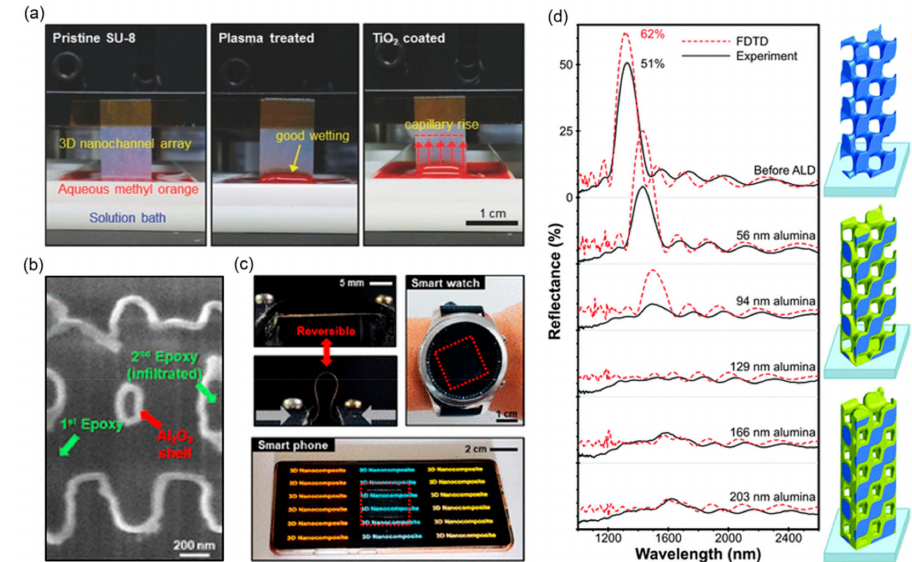
Figure 6. Application of inorganic shell-polymer nanonetwork composites: ( a ) comparison of hydrophilicity before and after conformal coating of TiO 2 thin film on ultralong nanochannel arrays formed by PnP (reprinted with permission from [23]. Copyright 2015 John Wiley and Sons); ( b ) cross-sectional SEM image of 3D continuous ceramic nanofiller-inserted polymer composite